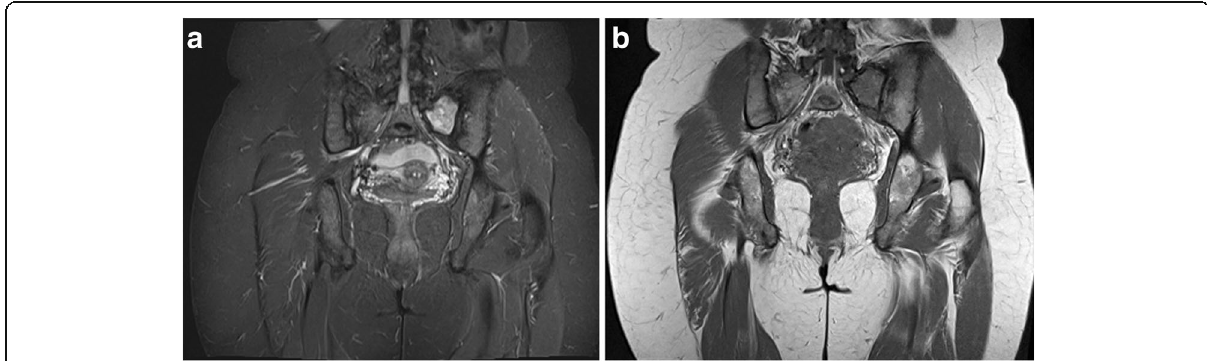
Fig. 6 a , b MRI of the same patient showed an incidental lesion in the left sacral ala — well-defined with high T2 and intermediate T1 signal